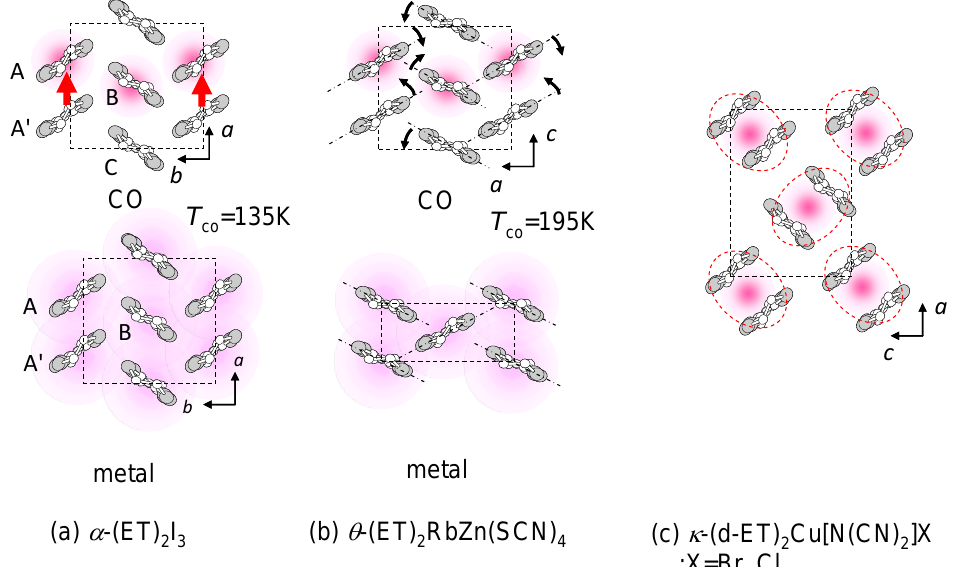
Figure 5. Schematic illustration of the molecular arrangement for ( a ) α-(ET) ( b ) θ - (ET) RbZn(SCN) ; ( c ) κ-(d-ET) Cu[N(CN) ]X (X = Br, Cl). Red circles and dashed 2 4 2 2 rectangles respectively denote the localized charge and the unit cell. Red arrows indicate the electric dipole moment induced by the